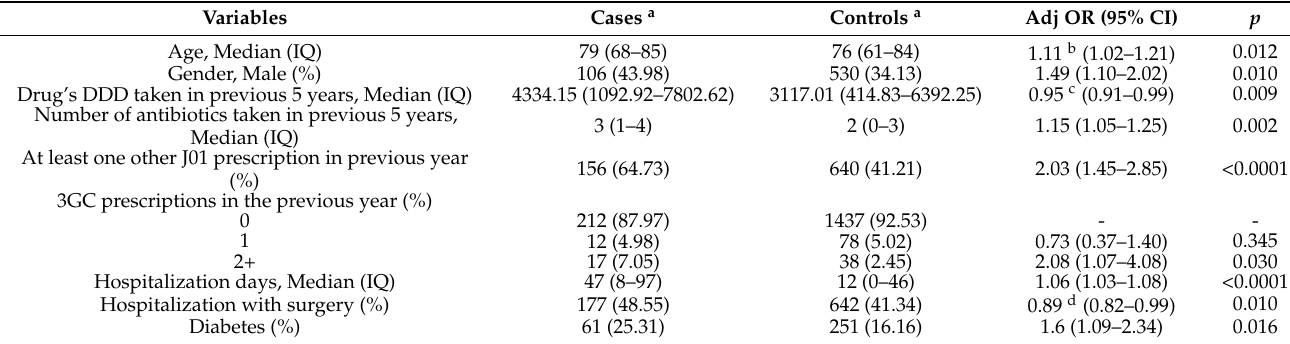
Table 3. Summarized results of multivariate analysis (backward step-wise approach) focused on 3GC use in the 12 months preceding